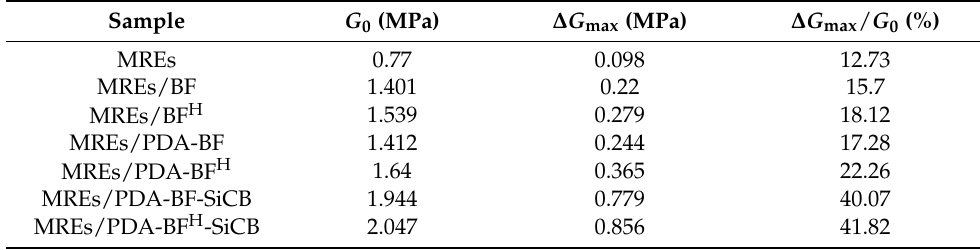
Figure 10. Elongation at break diagram ( a ) Shore hardness diagram ( b ) Tear strength diagram ( c ) of each group of MREs. Table 5. The MR effect of each sample.